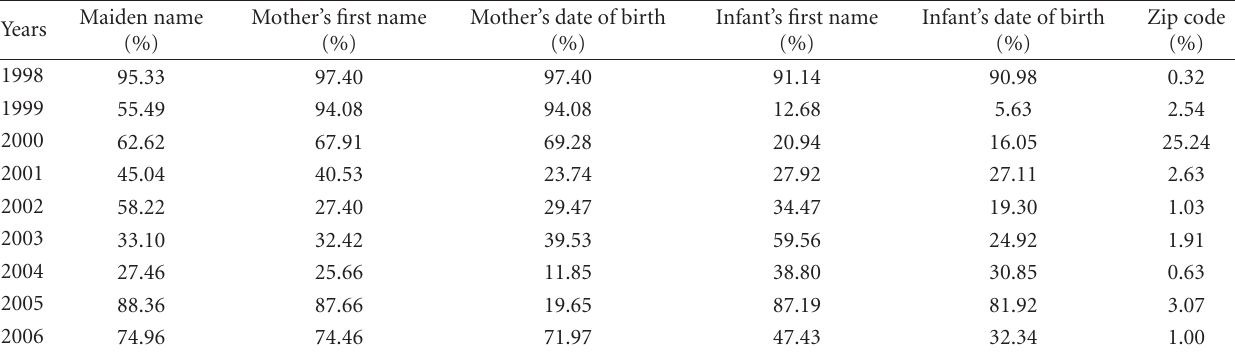
Table 3: Percentages of missing data for each identification item, among false negatives, for each year.